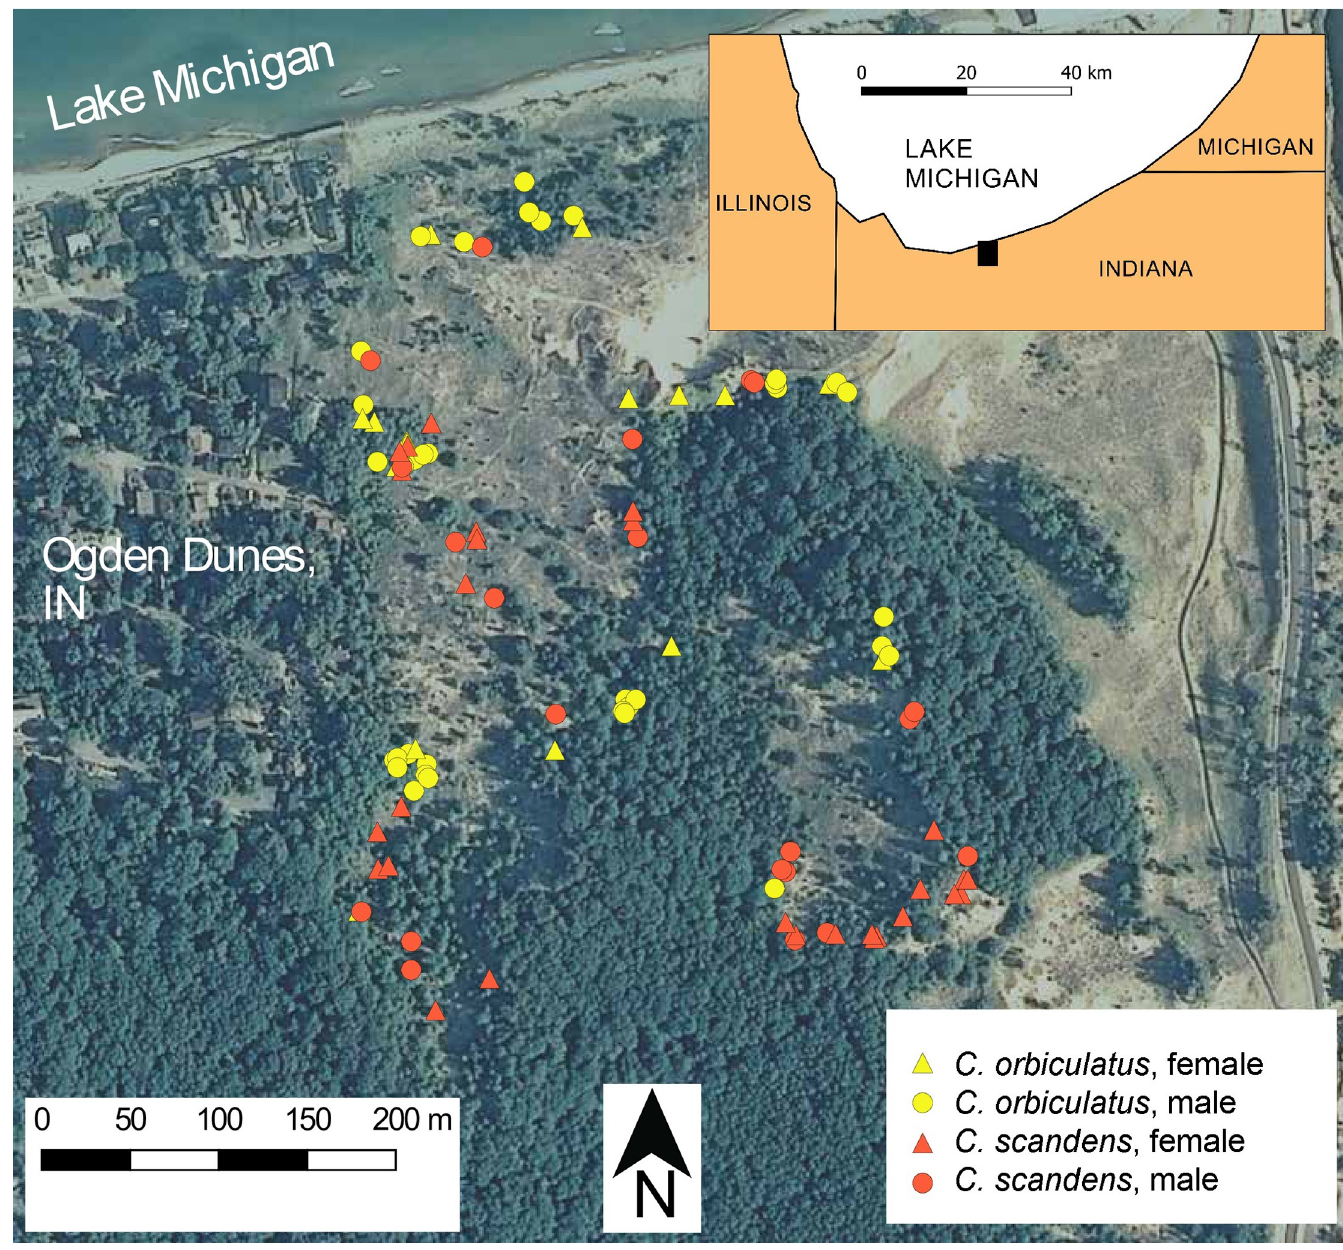
Fig 1. Spatial distribution of focal Celastrus individuals at the Portage Lakefront study site, Indiana Dunes National Park, Indiana, USA. Aerial imagery was accessed through the U.S. Geological Survey’s National Map Viewer, and collected by the National Agriculture Imagery Program (U.S. Department of Agriculture) in the year of the study,